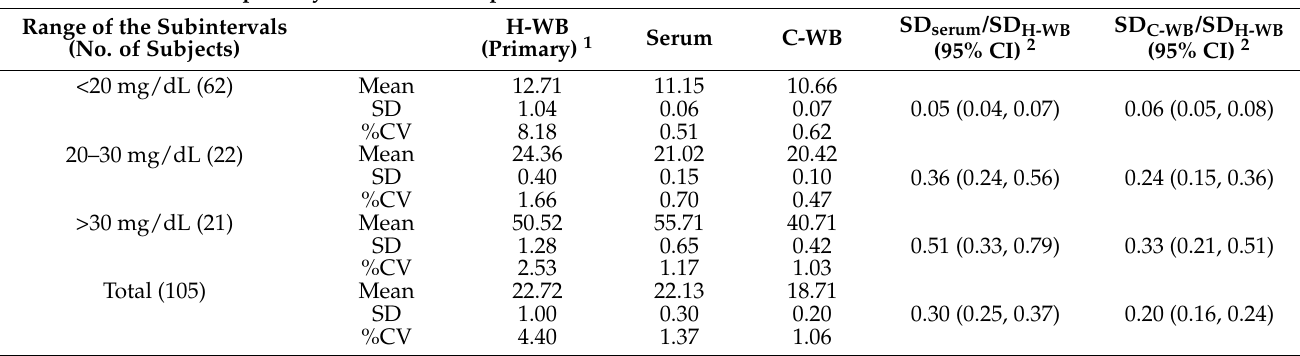
(B) SD ratios between primary and candidate specimens for BUN Range of the Subintervals (No. of